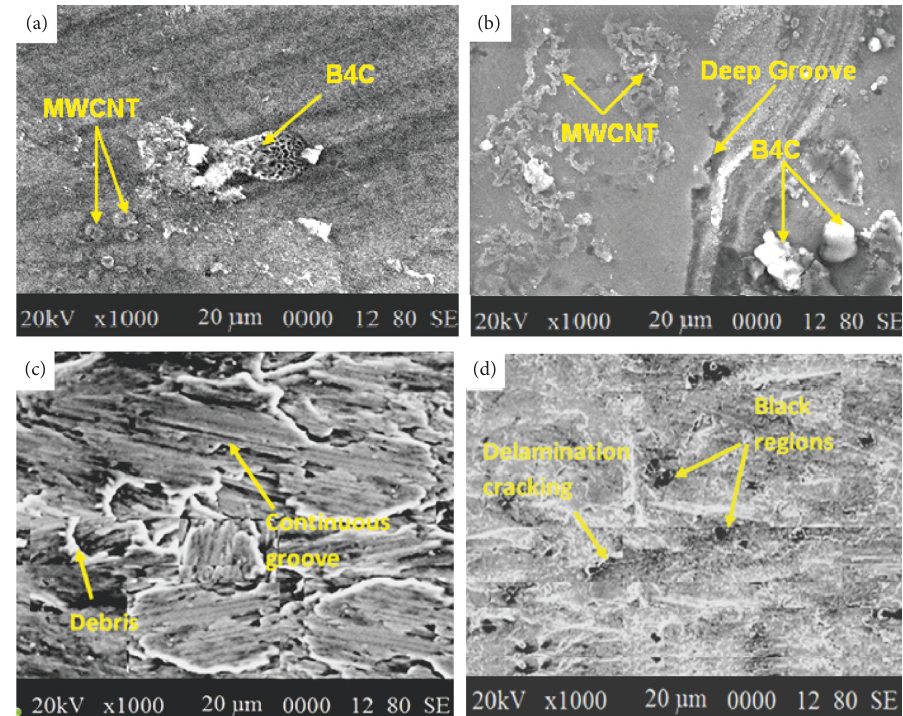
Figure 15: SEM images: (a) before wear test; (b) before corrosion test; (c) after wear test; (d) after corrosion